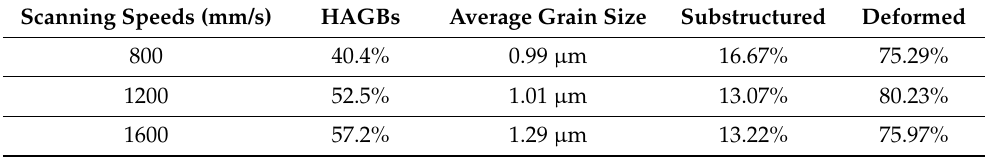
Table 3. Statistics of EBSD test results under different scanning speeds.